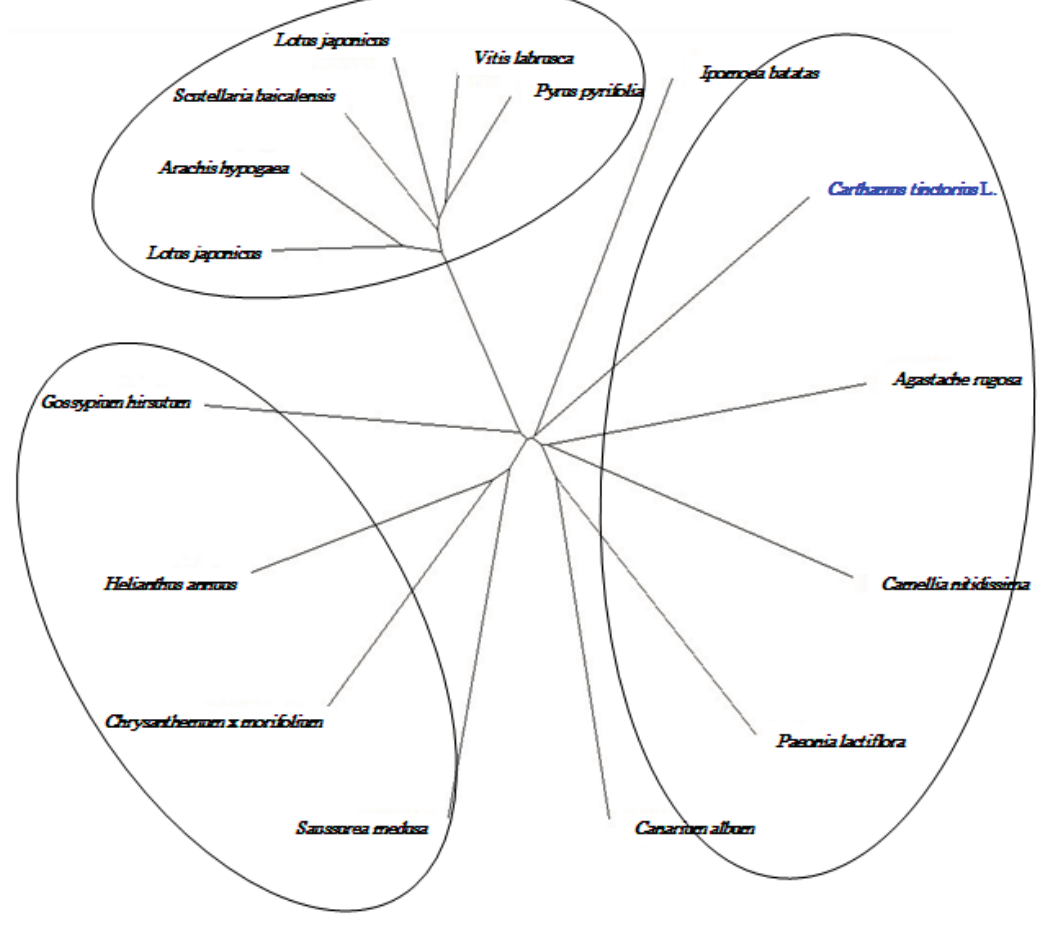
Figure 12. Phylogenetic tree of CHI gene from Safflower and other species. CHI gene in safflower has high homologywith Ipomoea batatas , Agastache rugosa , Camellia nitidissima , Paeonia lactiflora and Canarium